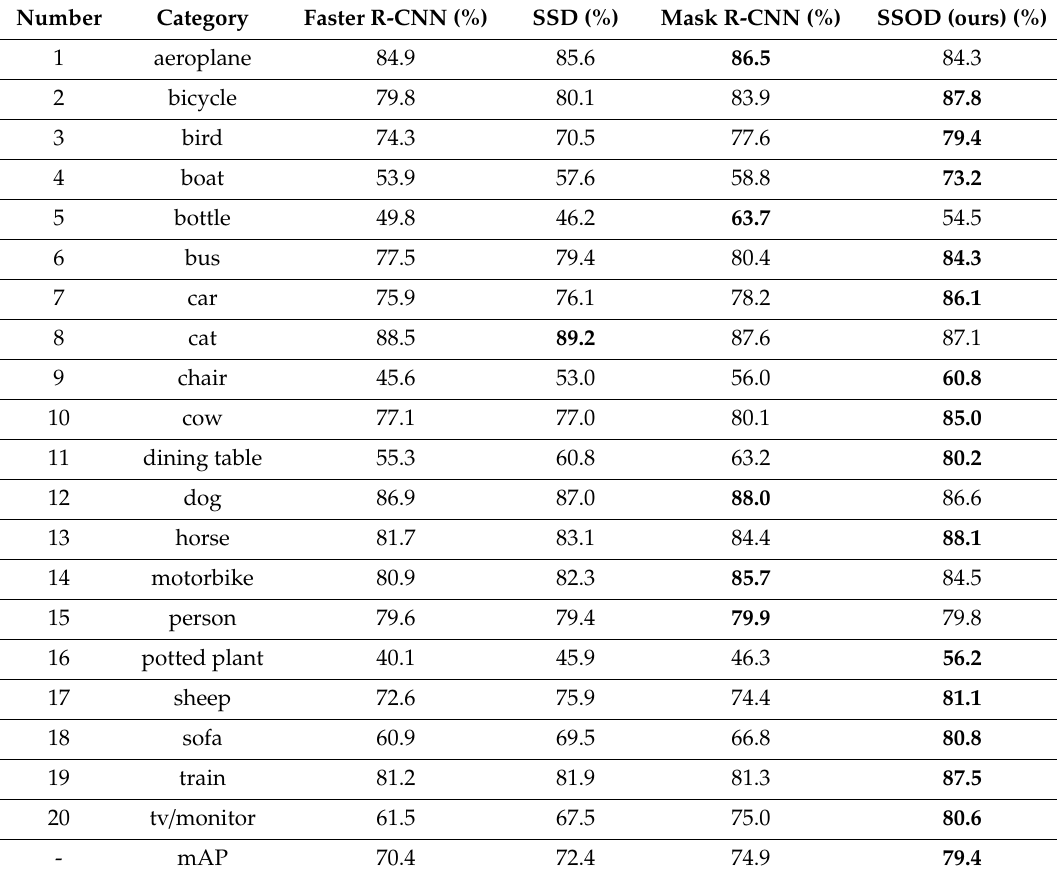
Table 2. Comparison of our method and other state-of-the-art methods in terms of mAP values (%) on the Pascal VOC 2012 dataset. The best accuracy is shown in